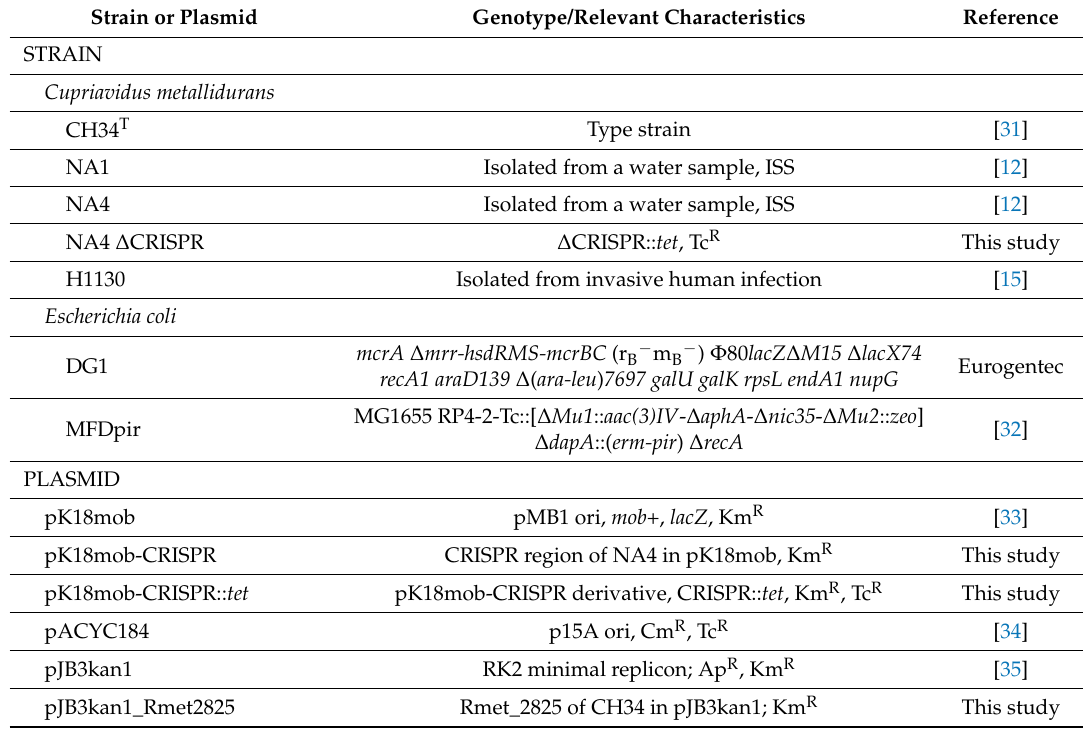
Table 1. Strains and plasmids used in this